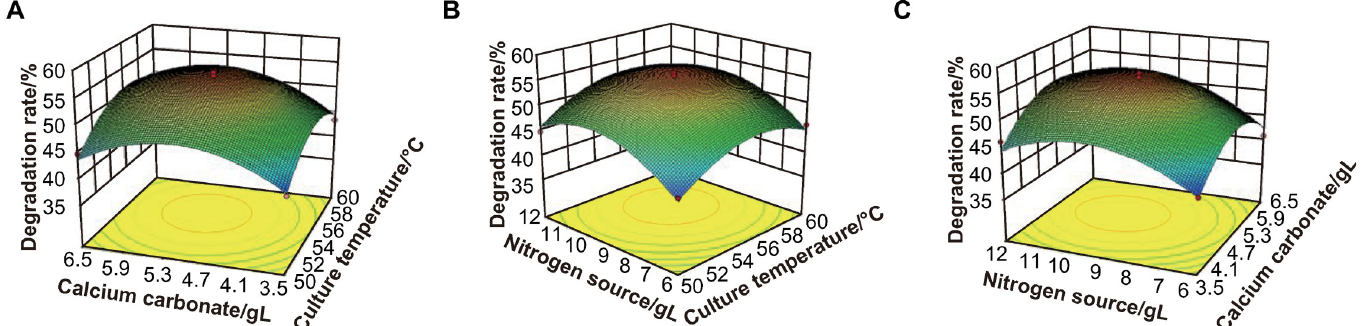
Fig 4. Three-dimensional response surface plots showing the effects of the interaction of culture temperature (A), calcium carbonate addition (B), and nitrogen source addition (C) on degradation rate of Yanshan ginger by YSJ.